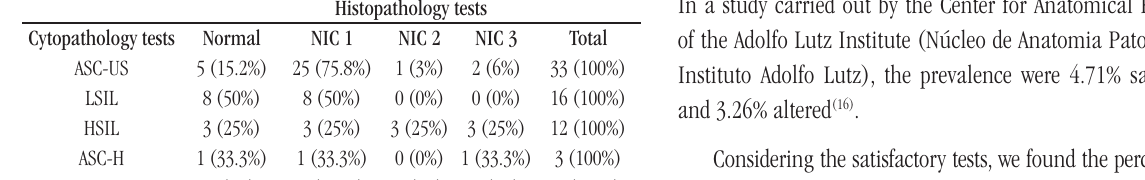
TABLE 1 – Correlation of cytopathology tests and histopathology tests Cytopathology tests